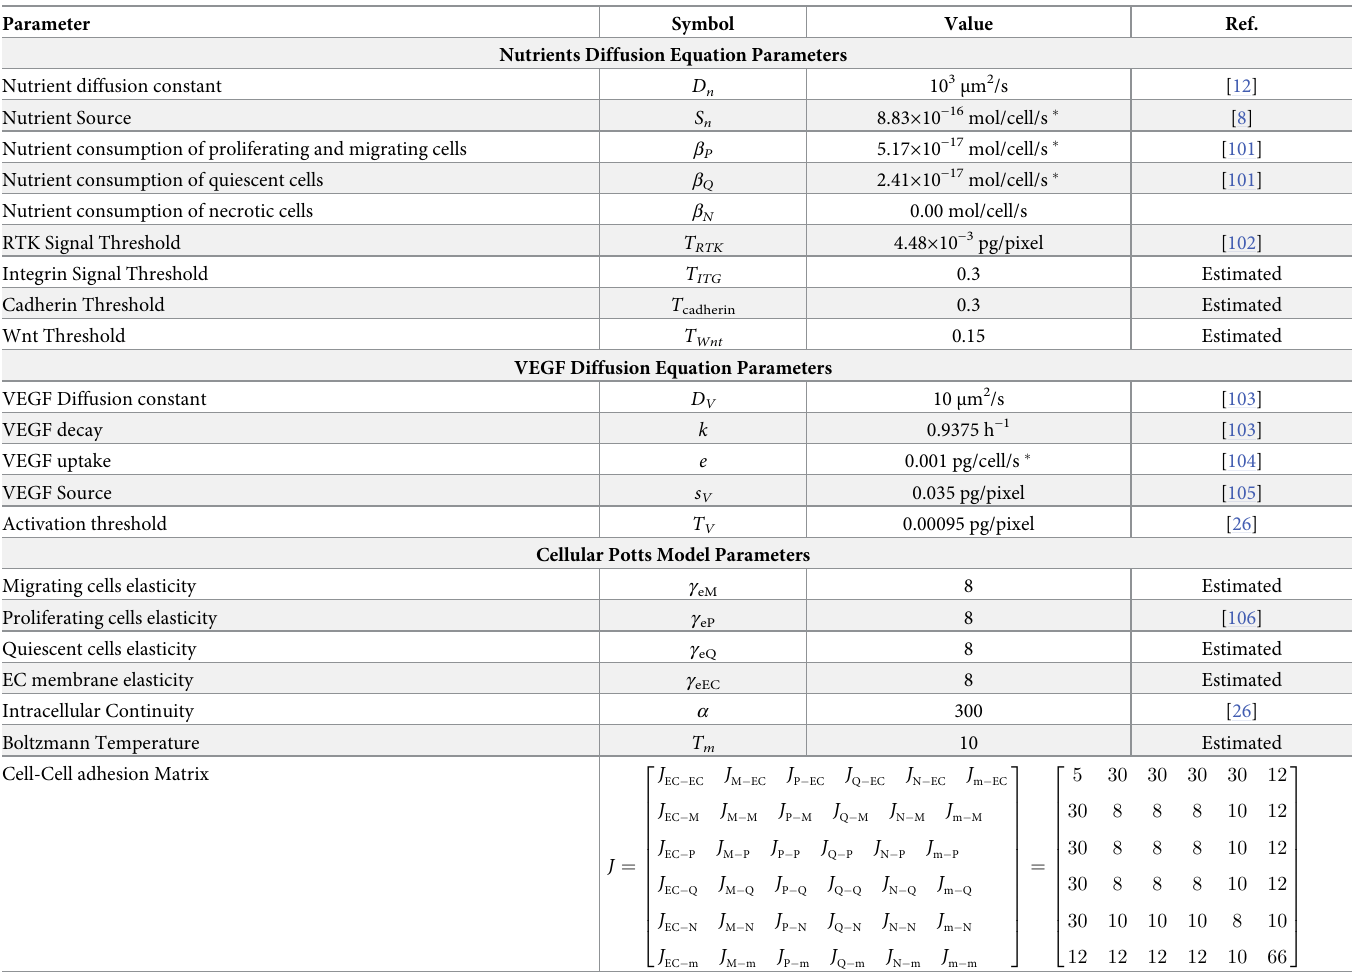
Table 2. Parameters used in the model and corresponding